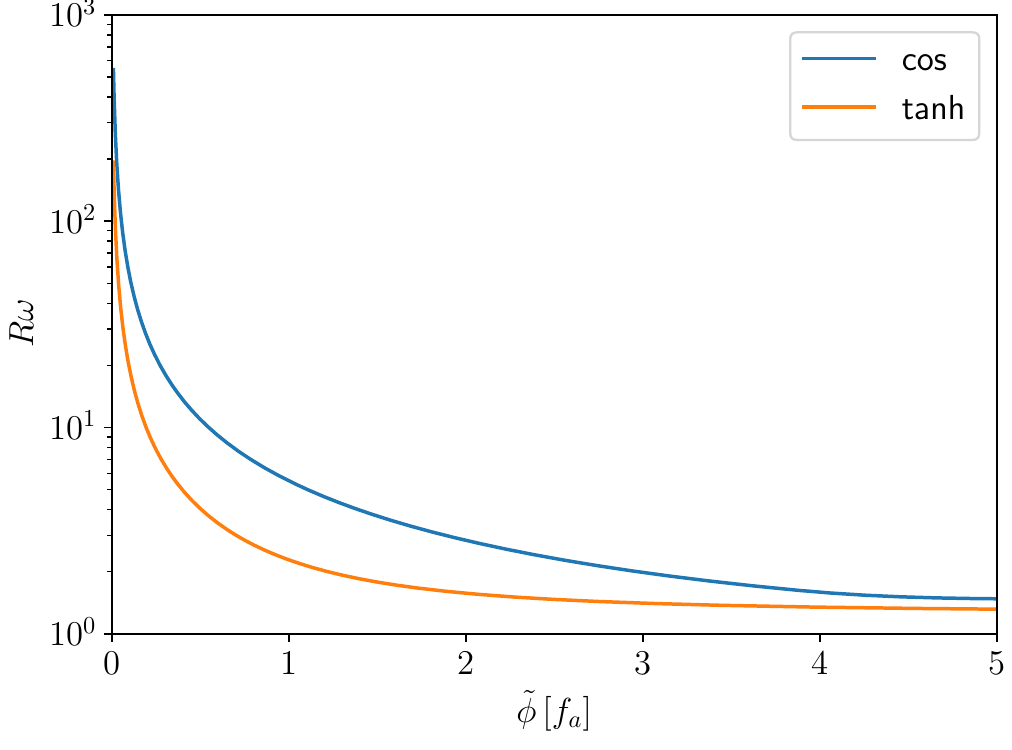
Figure 2 . The product of the clump size R (as defined in the text in eq. (3.1)) and ω as a function of the central amplitude ˜ φ (in units of f a ) for the cos- and